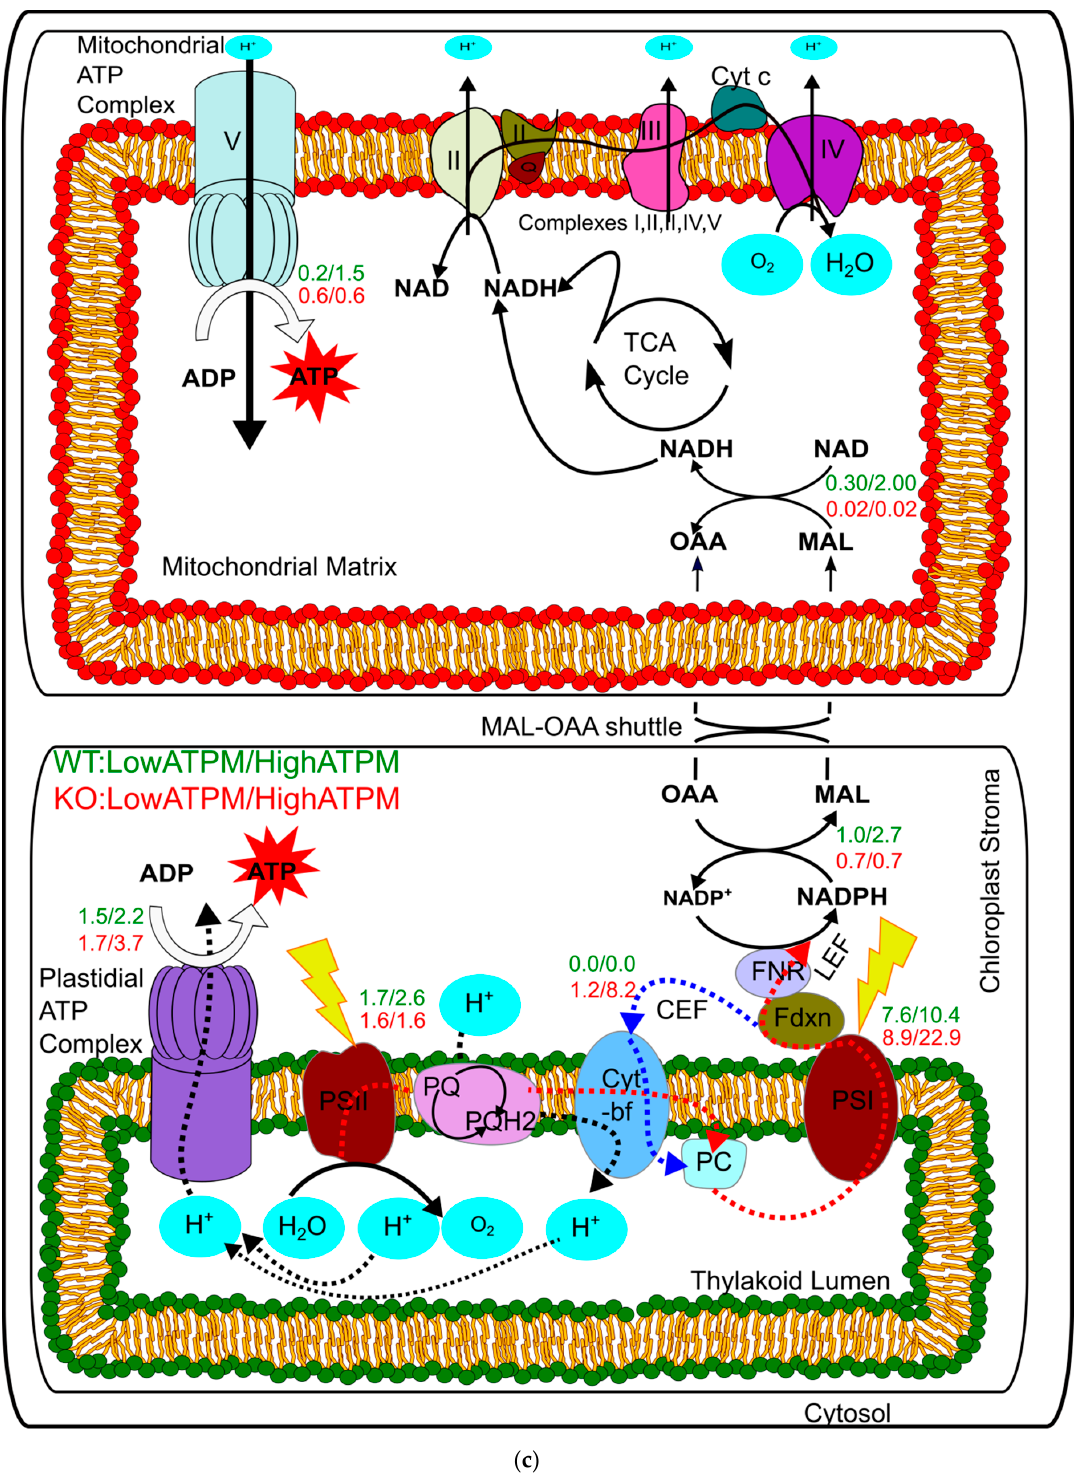
Figure 4. Simulated effect of variation of maintenance ATP (ATPM) values on metabolism. ( a ) Effect of ATPM values on the ratio of mitochondrial and plastidial ATP synthesis. The flux through ATPM reaction was varied and the effect on plastidial and mitochondrial ATP synthesis reactions was simulated. ( b ) Effect of ATPM values on flux through different reactions of the model, i Thaps987. PSI: Photosystem-I, PSII: photosystem-II, Photon_tx: Photon transport, Plastidial_ATP_Synthase: Plastdial ATP synthesis reaction, Mitochondrial_ATP_Synthase: Mitochondrial ATP synthesis reaction,